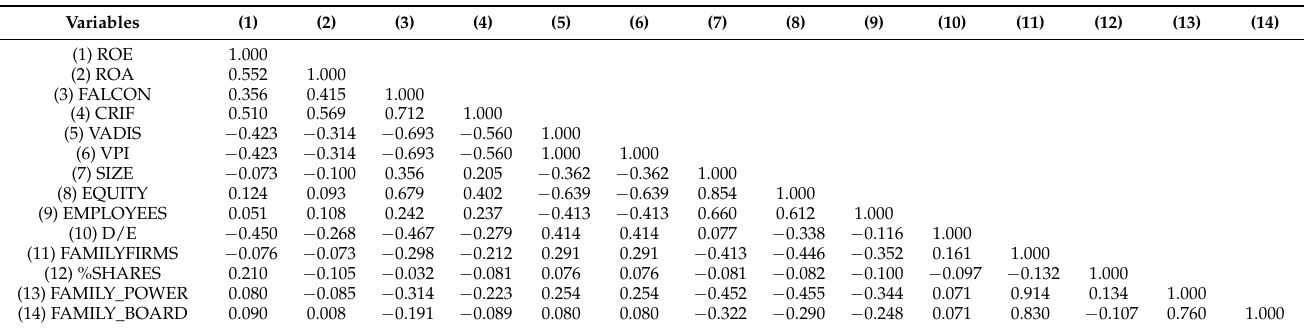
Table 3. Correlation